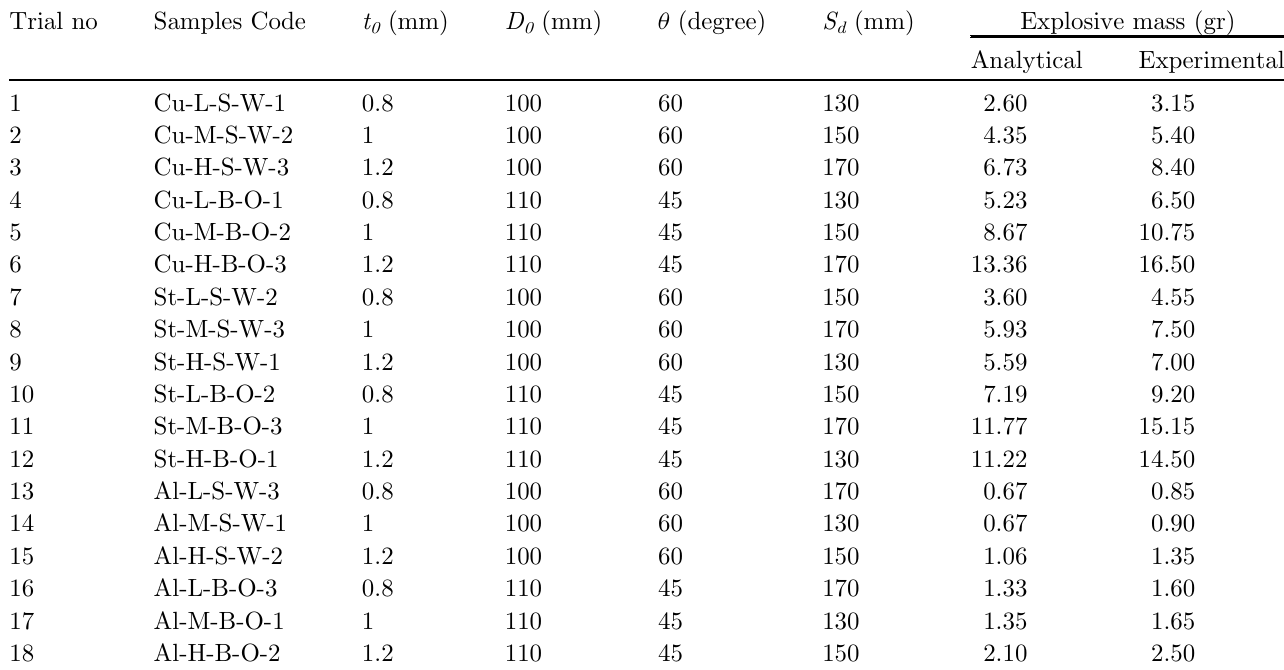
Table 3. Analytical and experimental results of explosive mass.